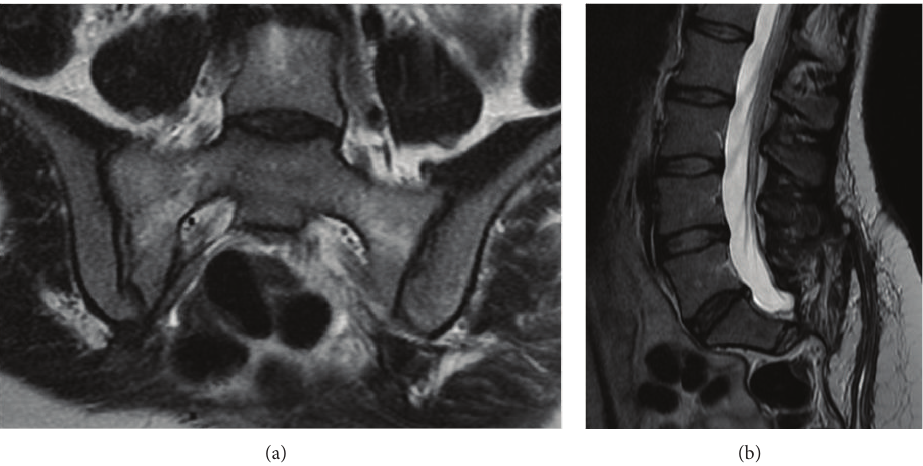
Figure 15: MRI scan evaluation 5 years after surgery, showing no recurrence of the tumor. (a) Coronal and (b) sagittal